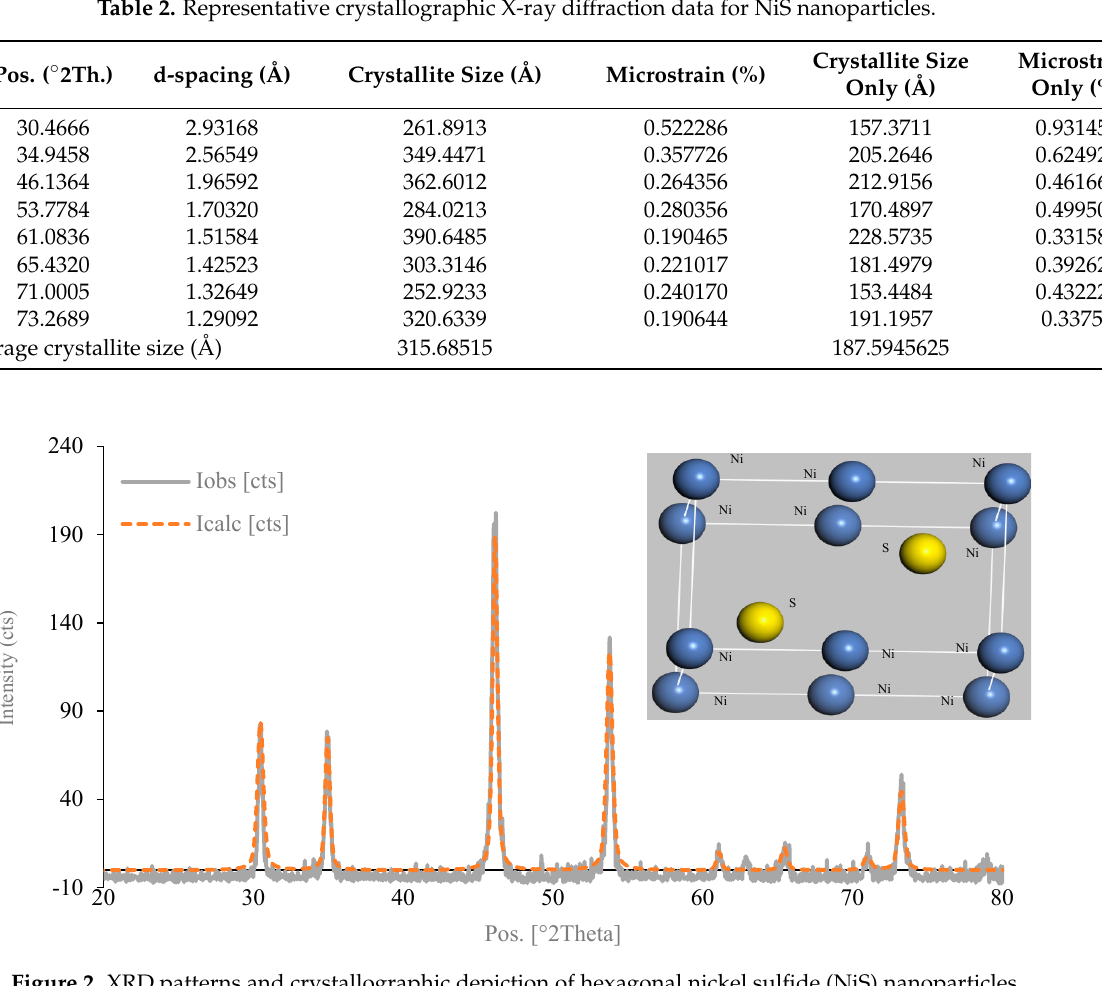
Figure 2. XRD patterns and crystallographic depiction of hexagonal nickel sulfide (NiS) nanoparticles. Table 2. Representative crystallographic X ‐ ray diffraction data for NiS nanoparticles. hkl Pos. (°2Th.)